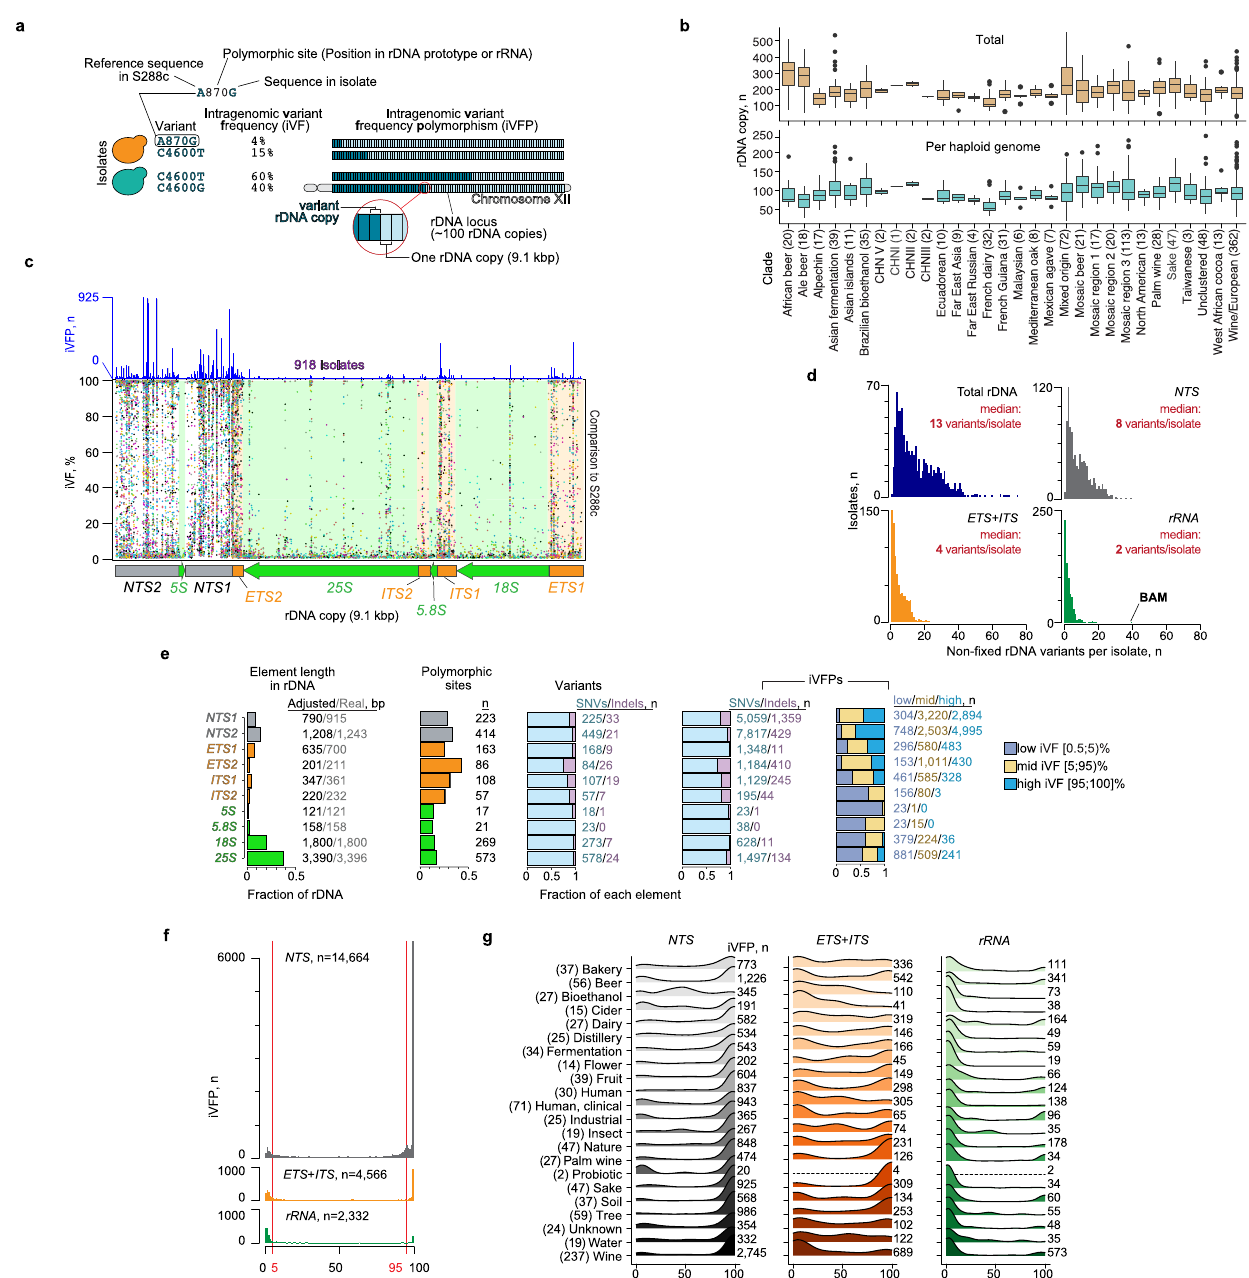
Fig. 1 | rDNA sequence variants across 918 S. cerevisiae isolates. a Variant annotation. Variants are de fi ned as nucleotide differences from the S288c proto- type (light blue). Intragenomic variant frequency (iVF) is the percentage of rDNA reads with a variant sequence within an isolate ’ s genome and is proportional to variant rDNA copies within a genome. Intragenomic variant frequency poly- morphisms(iVFP)areshownin darkblue.Oneisolatecanhavemultiplesequences at a position and thus the sum of the iVFPs can be more than the total number of isolates. b rDNA copy number distribution across isolates grouped by clade. Numbersinbracketsindicatethenumberofisolatesineachclade.Thecenterlineis the median, box limits are 25th and 75th percentiles, and the whiskers extend to ±1.5xIQR(interquartile range).Dotsshowisolateswithvaluesoutsidethewhiskers. c iVFPs(dots)comparedtothereferenceS288crDNAprototypeareplottedagainst one rDNA copy. Colors re fl ect different isolates (some isolates have same colors because of palette constraints). An rDNA copy is shown. The histogram above